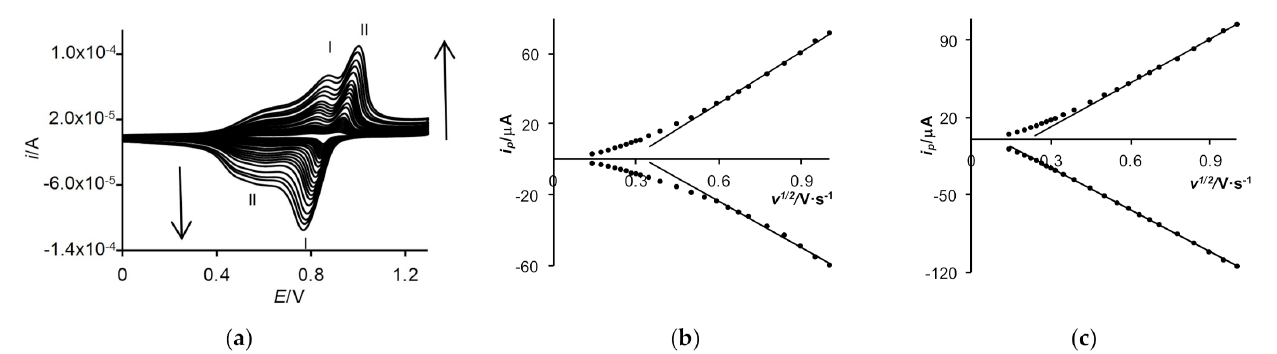
Figure 11. Poly [Ni(salcn(Bu))] (10 electropolymerization cycles) in TBAClO 4 /CH 2 Cl 2 , Pt, v = 0.02–1 V · s − 1 , vs. Ag/AgCl; ( a ) cyclic voltammograms; ( b ) plots i p vs. v 1/2 for 1st oxidation step of the process and 2nd reduction step ; ( c ) plots i p vs. v 1/2 for 2nd oxidation step of the process and 1st reduction step. I and II—peaks